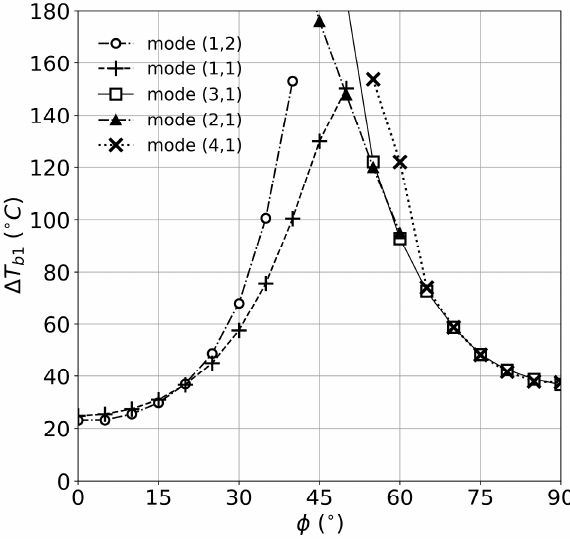
Figure 6. Linear buckling temperatures for [ θ / − θ ] (cid:2870)(cid:3046) laminates.